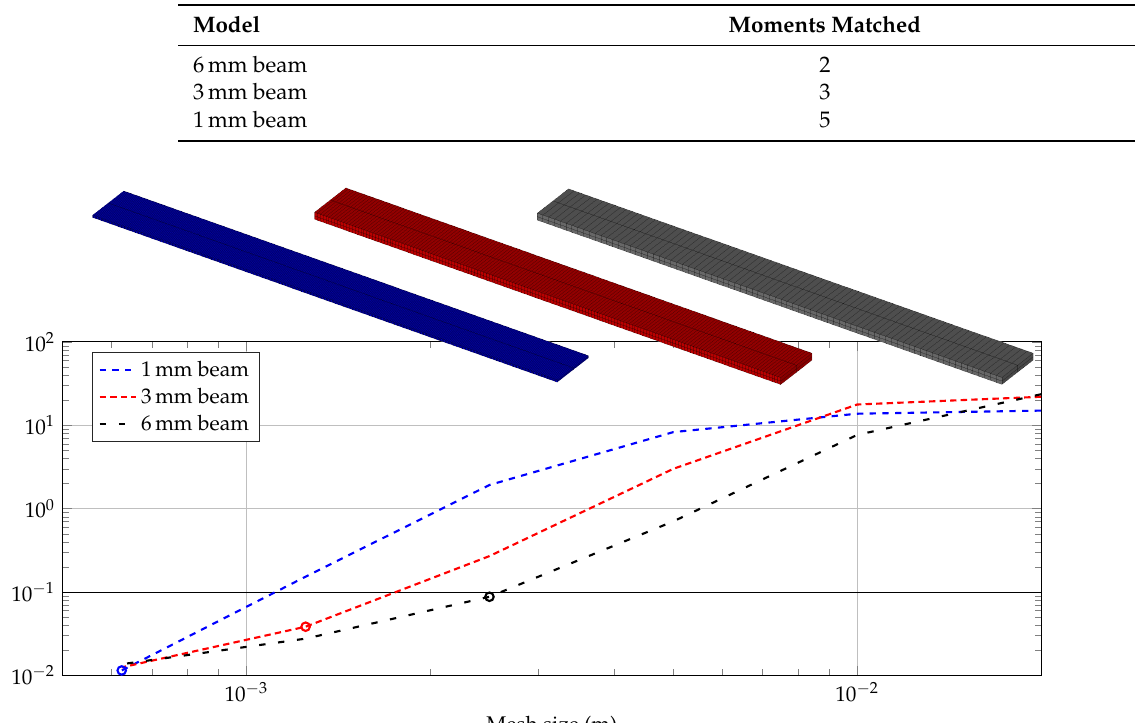
Figure 9. Maximum error in dependency on mesh sizes for each beam specimen with two elements over the beam’s thickness (chosen mesh size marked with circle).